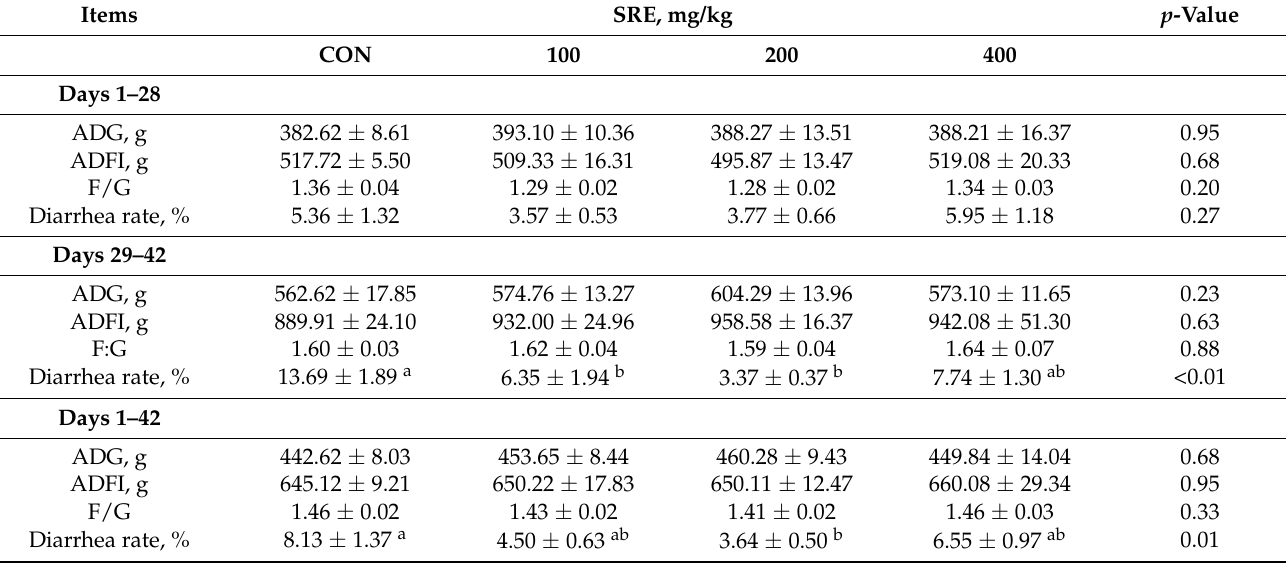
Table 3. Effects of supplementation with stevia residue extract in the diet on performance and diarrhea rate of weaned piglets (a)